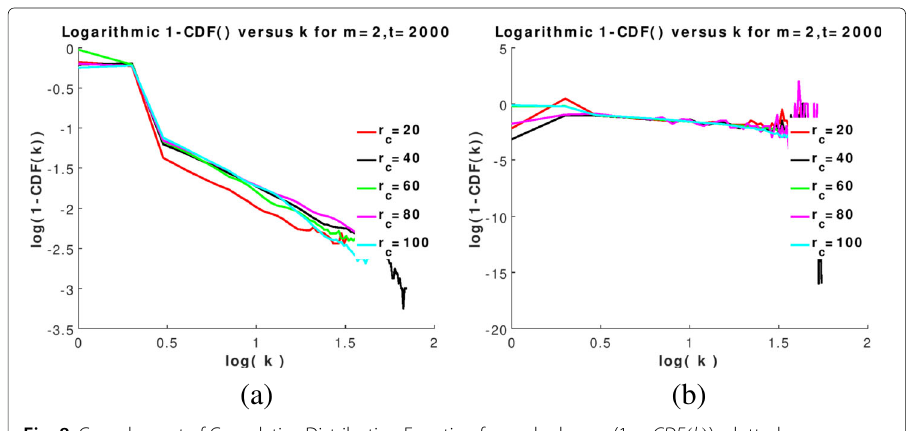
Fig. 8 Complement of Cumulative Distribution Function for node degree (1 − CDF ( k ) ), plotted on a logarithmic scale. The graphs are generated according to Eq. (2) on the left hand side, and using the constrained attachment probability in Eq. (27) with a top capacity of c = 50. All graphs are generated with a valence of m = 2 and arrested at t = 2000. The distribution for the constrained model demonstrates how a top constraint effectively flattens the scale free distribution to a uniform one with the presence of a maximum value of k = c . a Logarithmic complement cumulative degree distribution, unconstrained, t = 2000. b Logarithmic complement cumulative degree distribution, constrained to c = 50 at t =